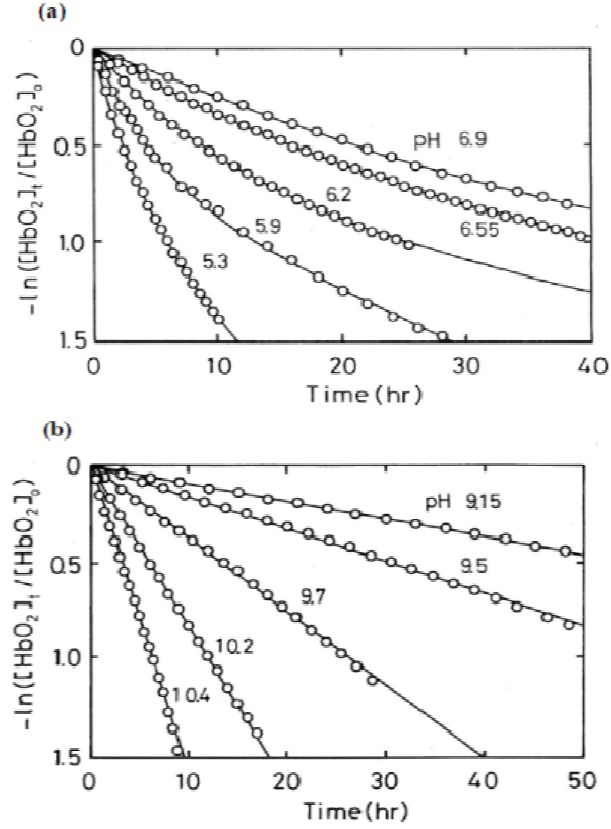
Figure 2. A –ln([HbO ] /[HbO ] ) versus time plot (first-order plot) for human HbO 2 t 2 0 autoxidation, redrawn from Sugawara et al . [16]. ( a ) Acidic autoxidation seen in acidic-to-neutral pH ranges and ( b ) alkaline autoxidation in alkali solutions. Solid lines represent the least-squares fitting to experimental data in each run. Conditions: HbO concentration was 50–125 μ M (in heme contents); and the reaction proceeded in 0.1 M buffer at 37